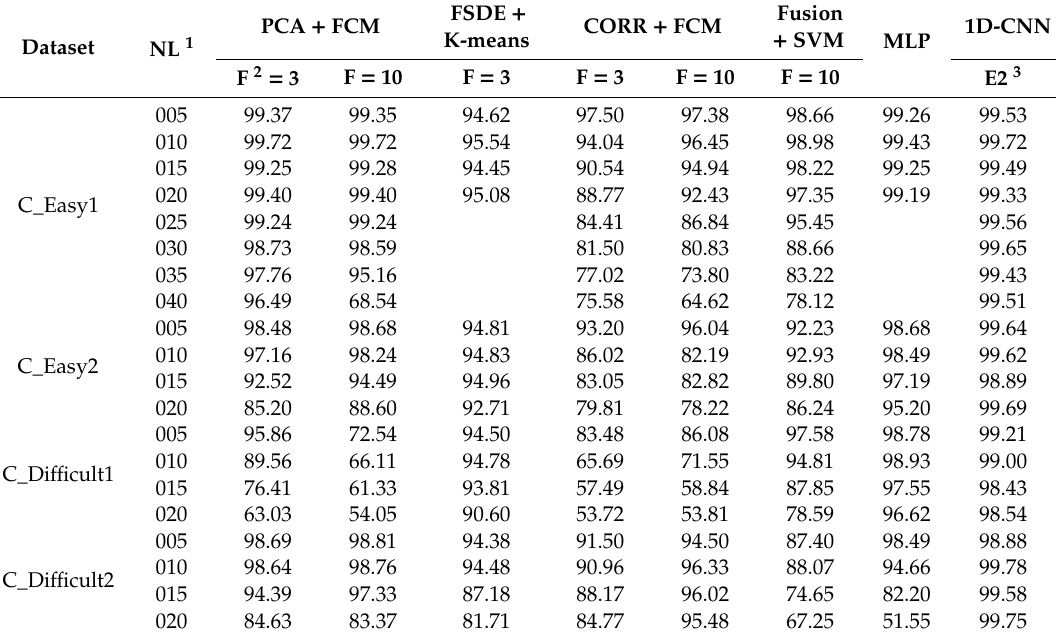
Table 2. Comparison of classification accuracy on simulated database (using traditional methods and deep-learning-based multilayer perceptron (MLP) model). PCA, principal component analysis; FCM, fuzzy C-means; FSDE, first and second derivative extrema; CORR, correlation-based; SVM, support vector